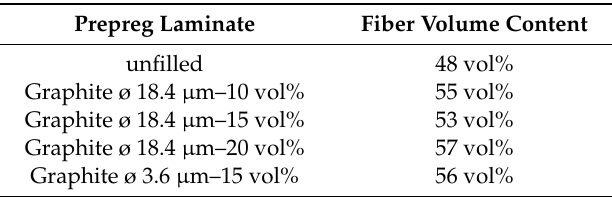
Table 2. Fiber volume content of the produced laminates.